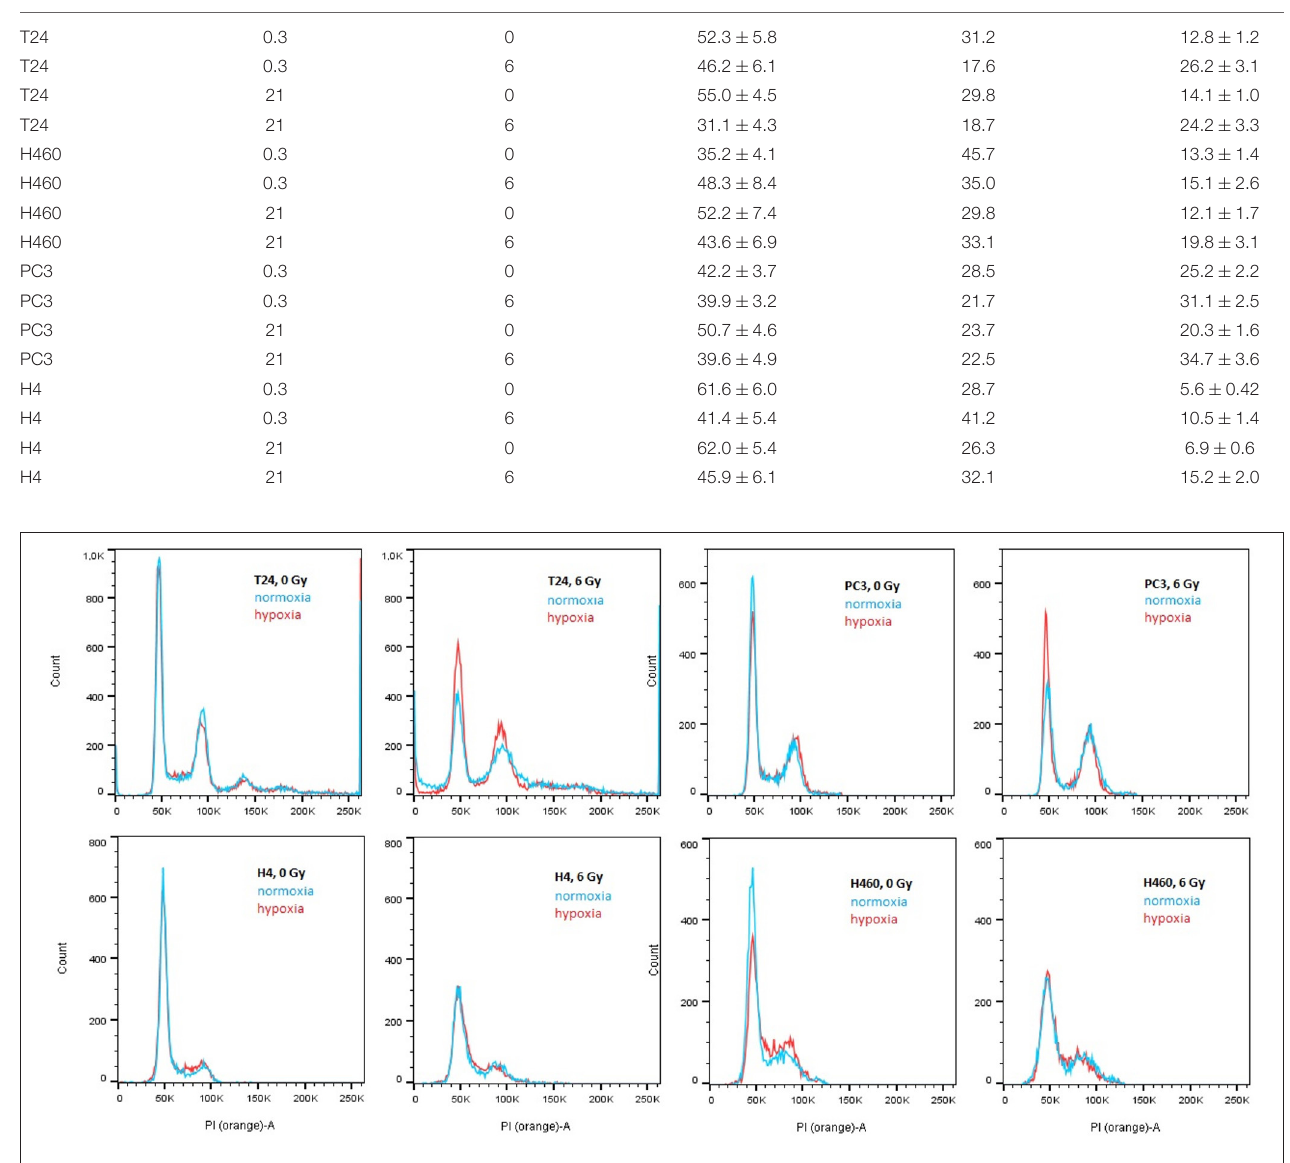
FIGURE 4 | PI spectra of T24, H4, PC3, and H460 72 h after irradiation with 6Gy compared to no radiation. Within each graph, normoxic (21% O 2 ) is compared to hypoxic (0.3% O 2 ) conditions. In all cell lines, irradiation causes a decrease in G1 phase and a relative increase in S and G2/M. The overall survival after irradiation in hypoxia is higher compared to no